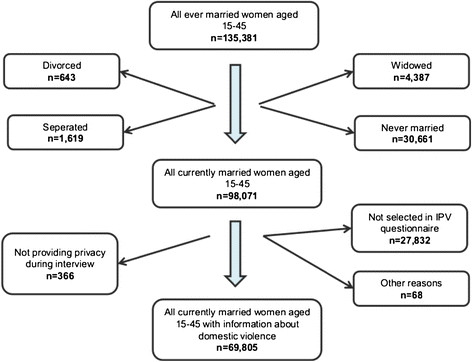
Numbers of excluded cases broken down to exclusion criteria.